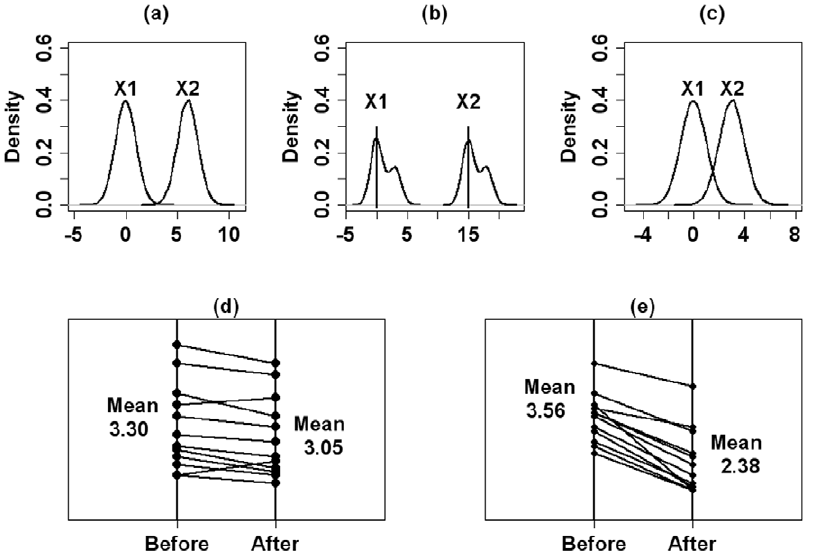
Figure 1. Example of different distributions of two random variables. Location and shape of two independent (1a, 1b, 1c) and two dependent random variables (1d and 1e).